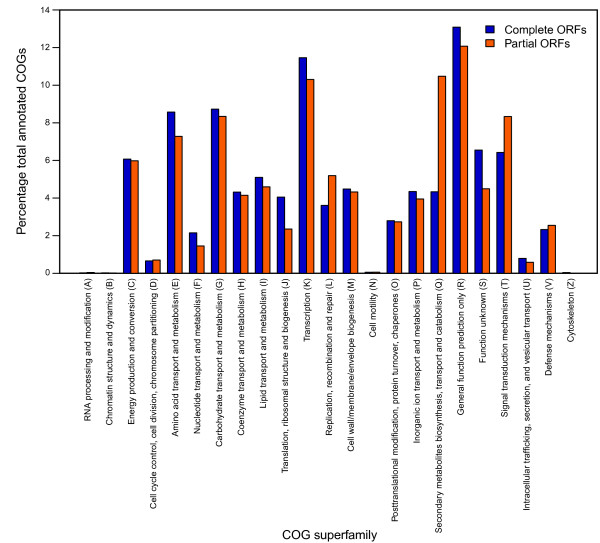
Mean partial and complete ORFs for each COG superfamily. The values shown are expressed as a percentage of the total number of partial or complete ORFs in the draft Streptomyces genomes examined. COG superfamily single-letter abbreviations are bracketed.